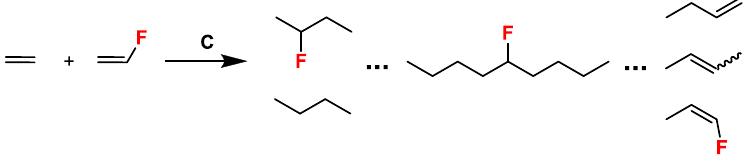
Figure 2. Molecular weight distributions of polyethylene (PE) [39] and ethylene/VF copolymer (Table 1, entry 4) generated by C determined by high temperature GPC. Polymerization conditions: hexanes solvent, 80 °C.